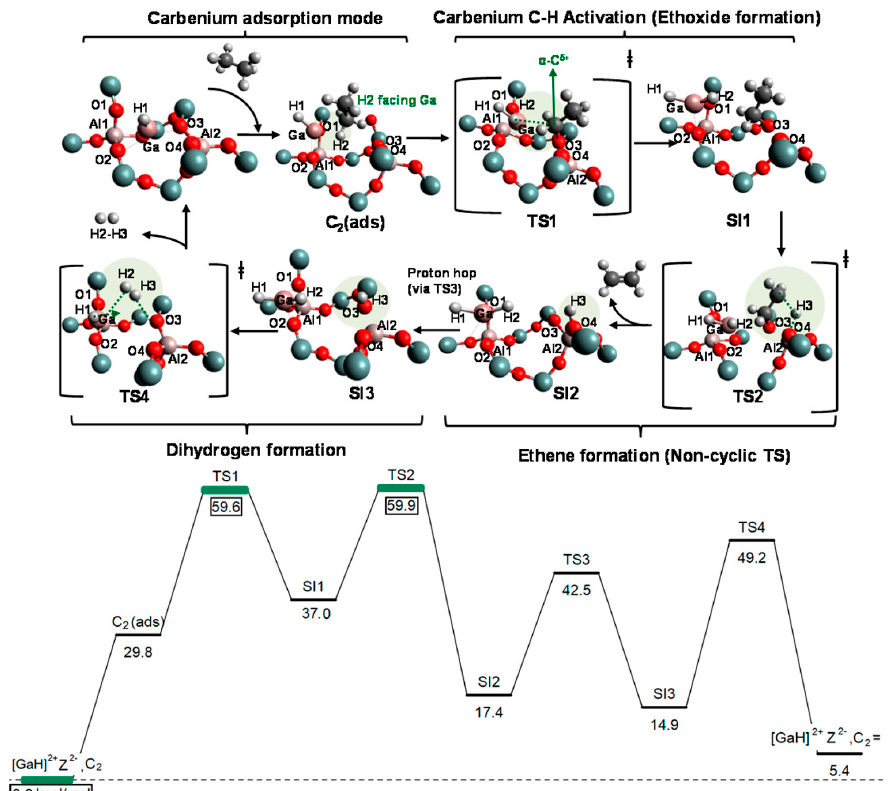
Figure 29. Ethane dehydrogenation via the carbenium mechanism (noncyclic route) on [GaH] 2+ (configuration B), and the corresponding free energy surface (kcal/mol), reported at 823 K and 1 atm. Reprinted with permission from ref [94]. Copyright 2018 American Chemical Society.